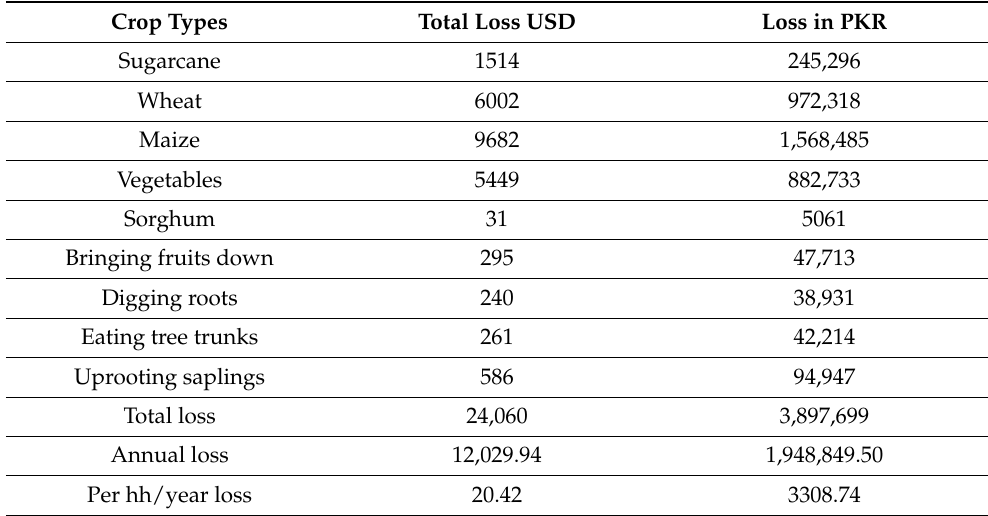
during the years 2020 and 2021.